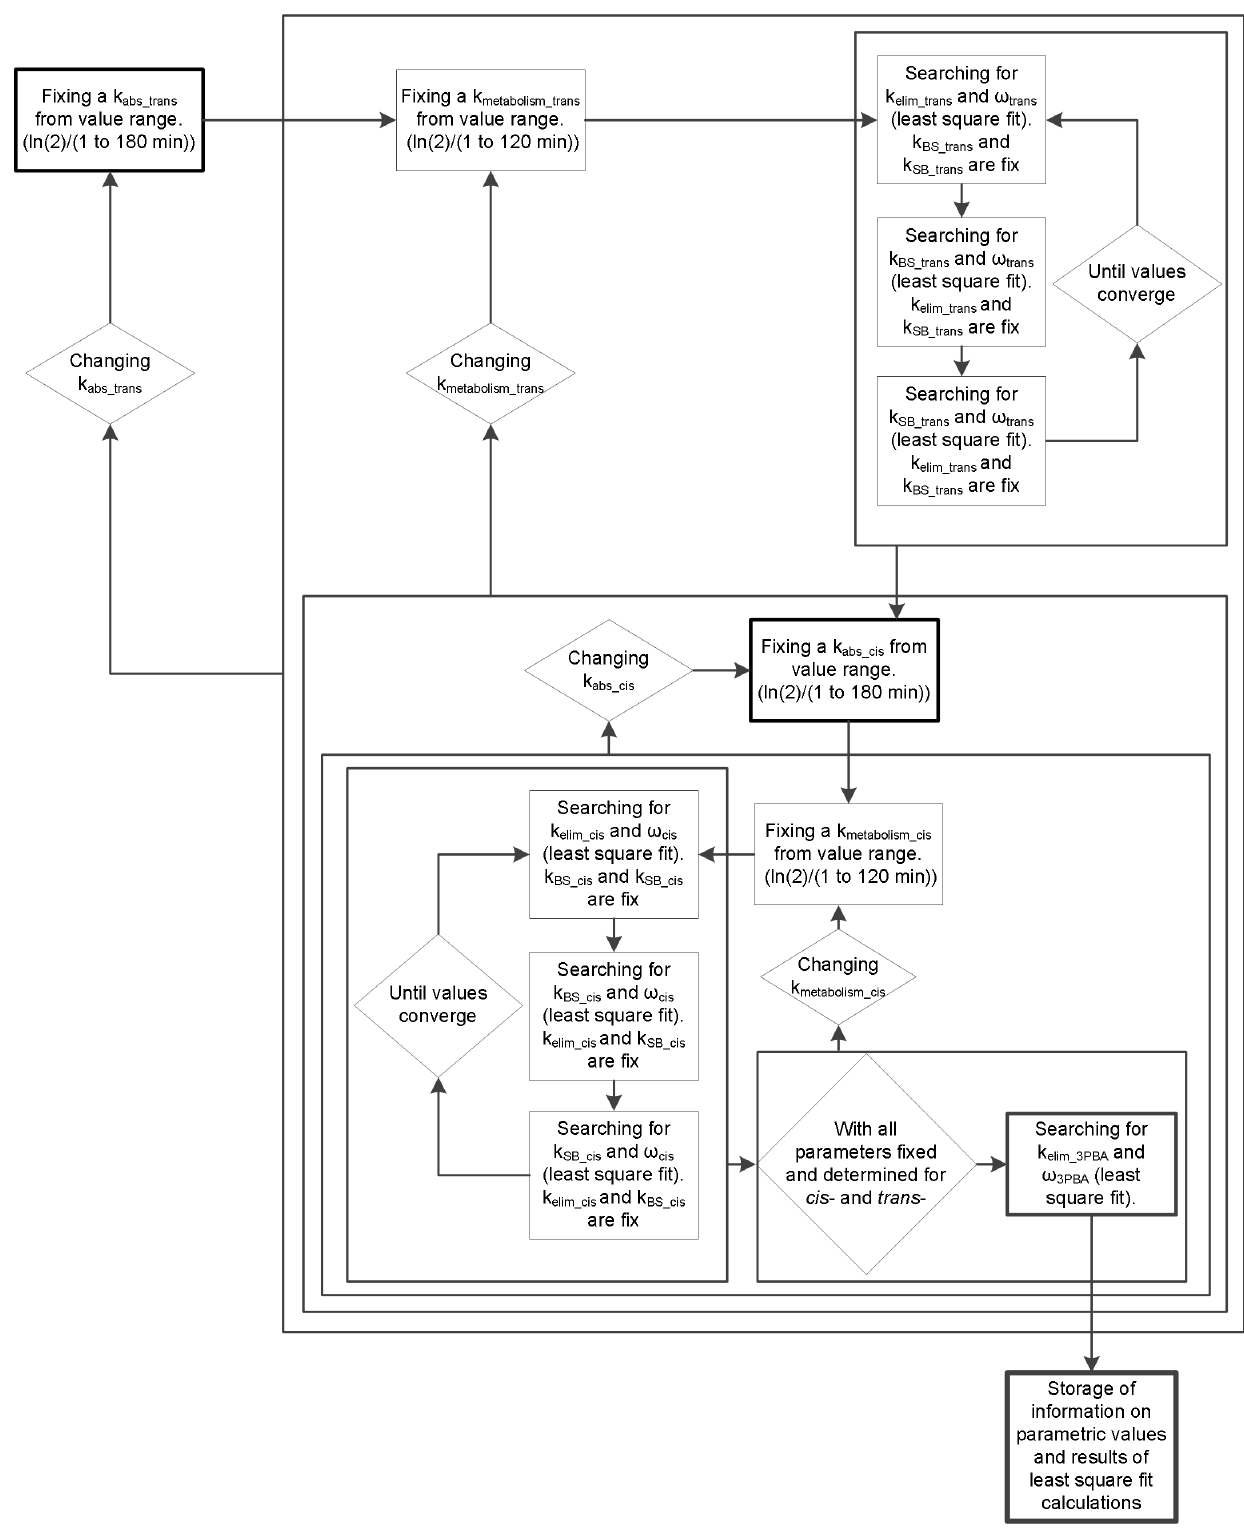
Figure 2. Algorithm. Algorithm for the determination of parameters values of the model with experimental data of urine excretion profile.